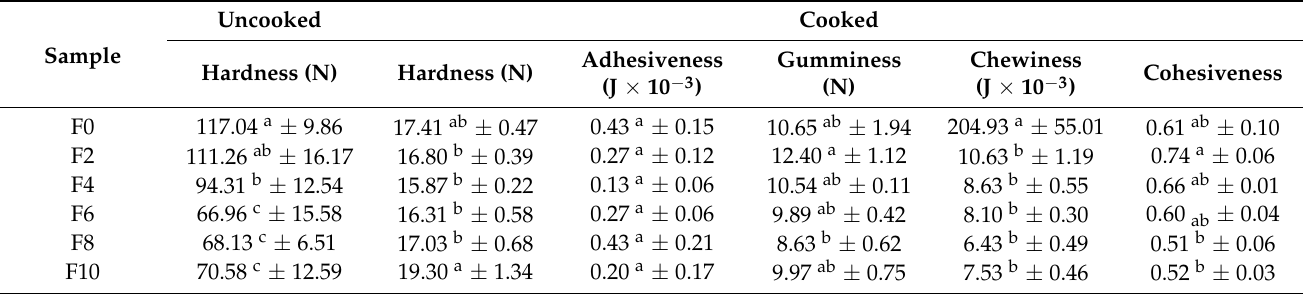
Table 5. Textural properties of uncooked and cooked noodles based on F0 and FRNs .